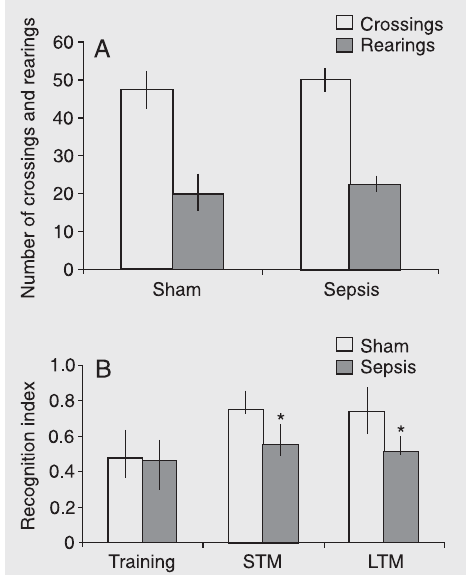
Figure 1. Object recognition task. No significant difference was observed in the numbers of crossings and rearings in the habituation session (Student t - test). Data are reported as means ± SEM (A). The sepsis group presented a significant impairment of novel object rec- ognition memory compared to the sham group (B). Results are reported as median (interquar- tile ranges) recognition indexes in training, short-term (STM) and long-term memory (LTM) reten- tion test trials. N = 10 animals per group. *P < 0.05 compared to the sham group (Mann-Whit- ney